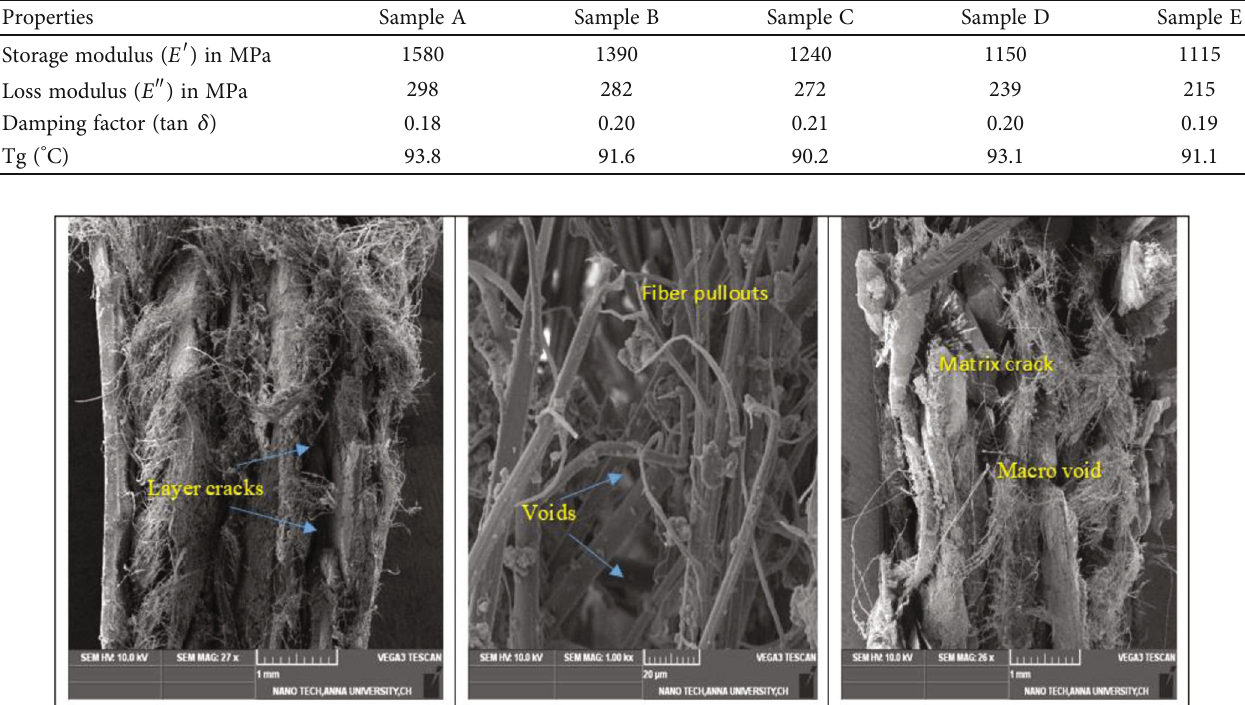
Table 4: Data of dynamic mechanical analysis.